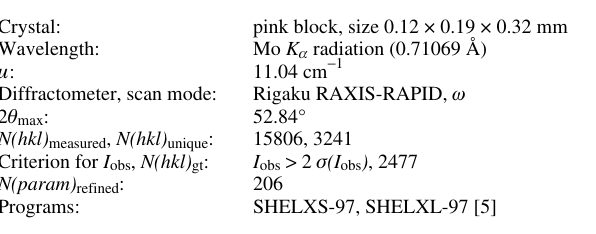
Table 1. Data collection and